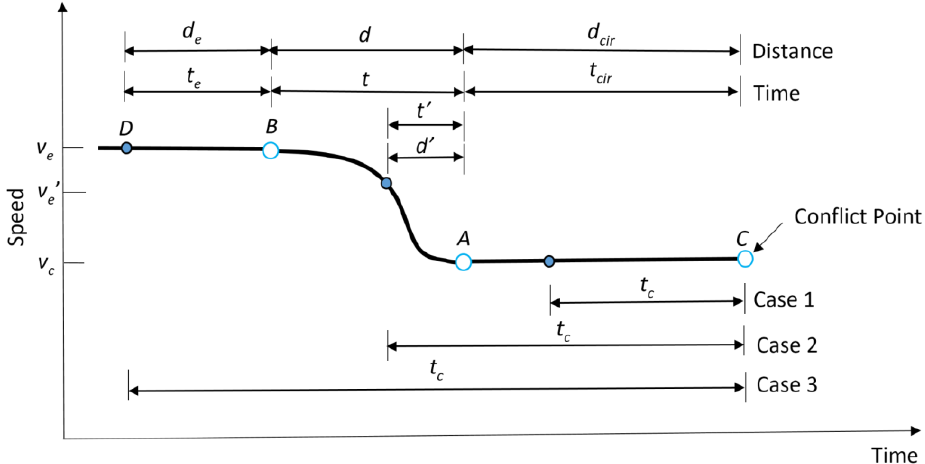
Figure 3. Geometry of the three cases for calculating D 1 . Note: C is the conflict point, CA is the distance along the circulatory roadway, AB is the deceleration distance, and BD is the distance along the entry approach (see Figure 2b).